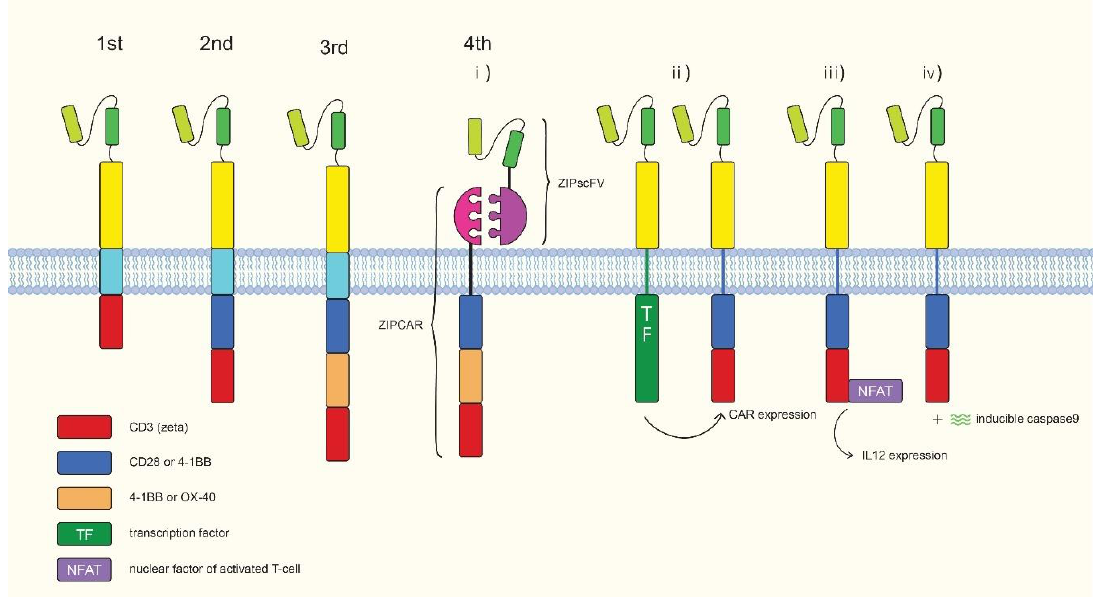
Figure 2. Overview of chimeric antigen receptors. Frist generation (chimeric antigen receptors) CARs